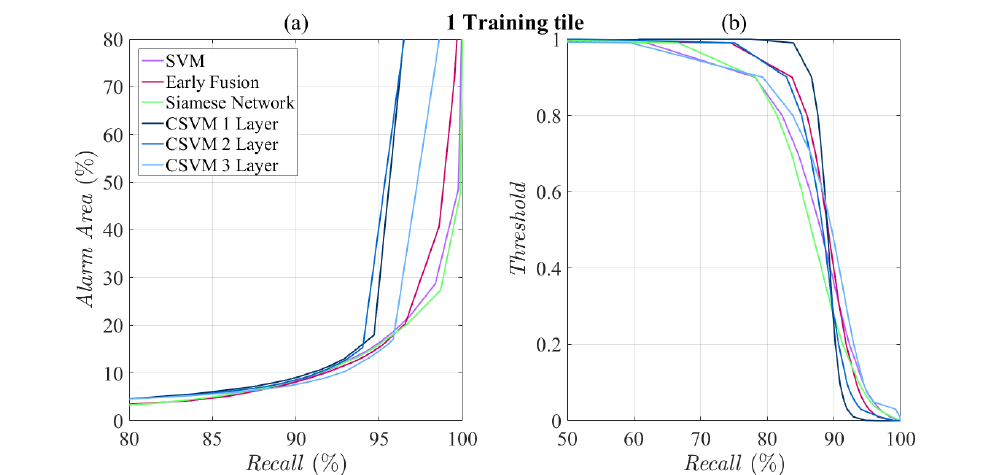
Figure 13. ( a ) Recall vs. Alarm Area (deforested area) for Amazon biome using one training tile. ( b ) The recall values are obtained by threshold variation.